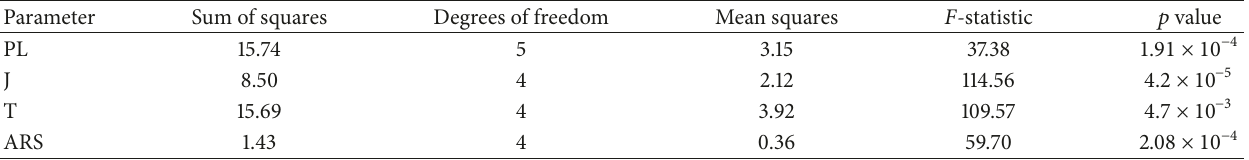
Table 12: Four-way ANOVA on MOS collected from 176 video sequences.